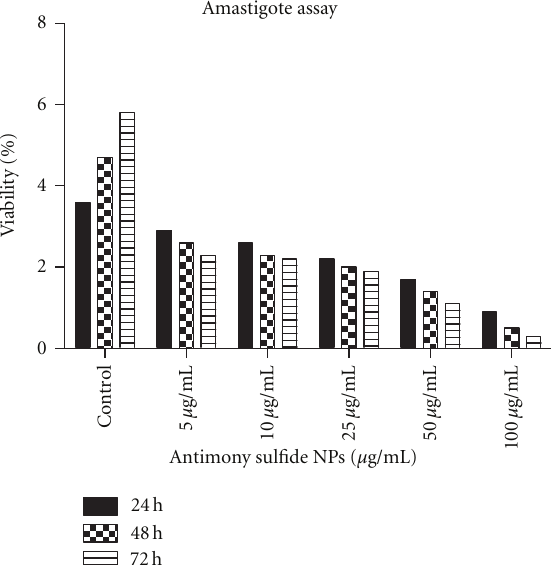
Figure 1: Viability of test and control groups of promastigote of L. infantum in 5 dilutions of antimony sulfide NPs during 24, 48, and 72 hours of incubation.